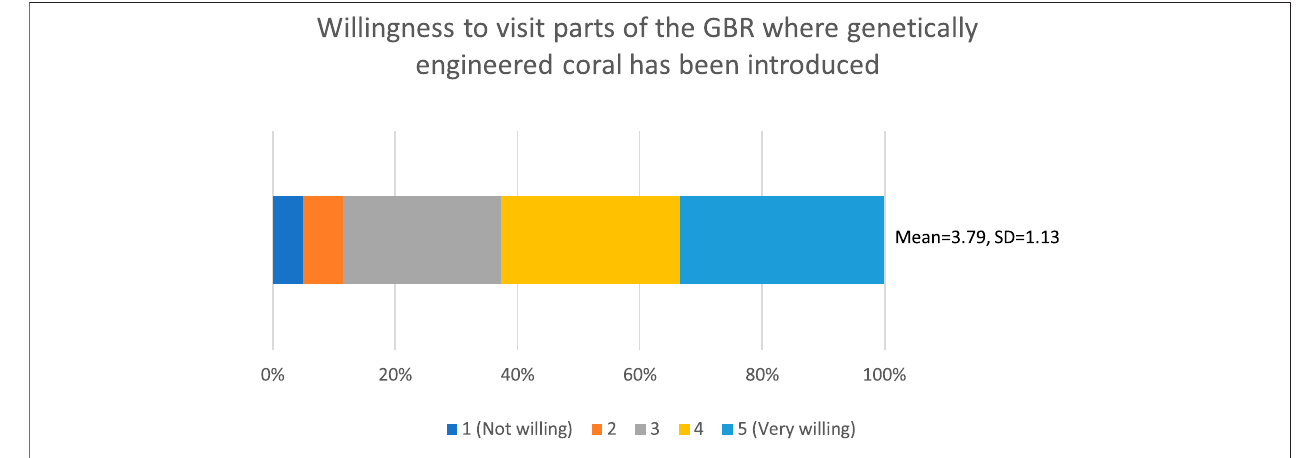
FIGURE 5 | Willingness to visit parts of the GBR where genetically engineered coral has been introduced.